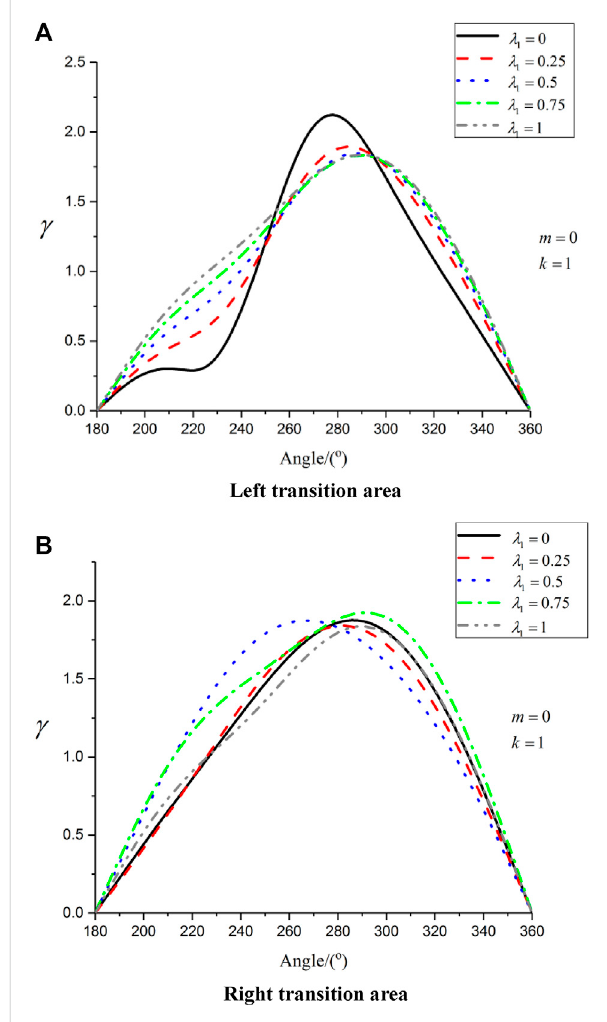
FIGURE 9 Distribution of hoop dynamic stress concentration factor with k (cid:2) 1 at semicircular depressions. (A,B) represent the results of these two subsets: Left transition area and Right transition